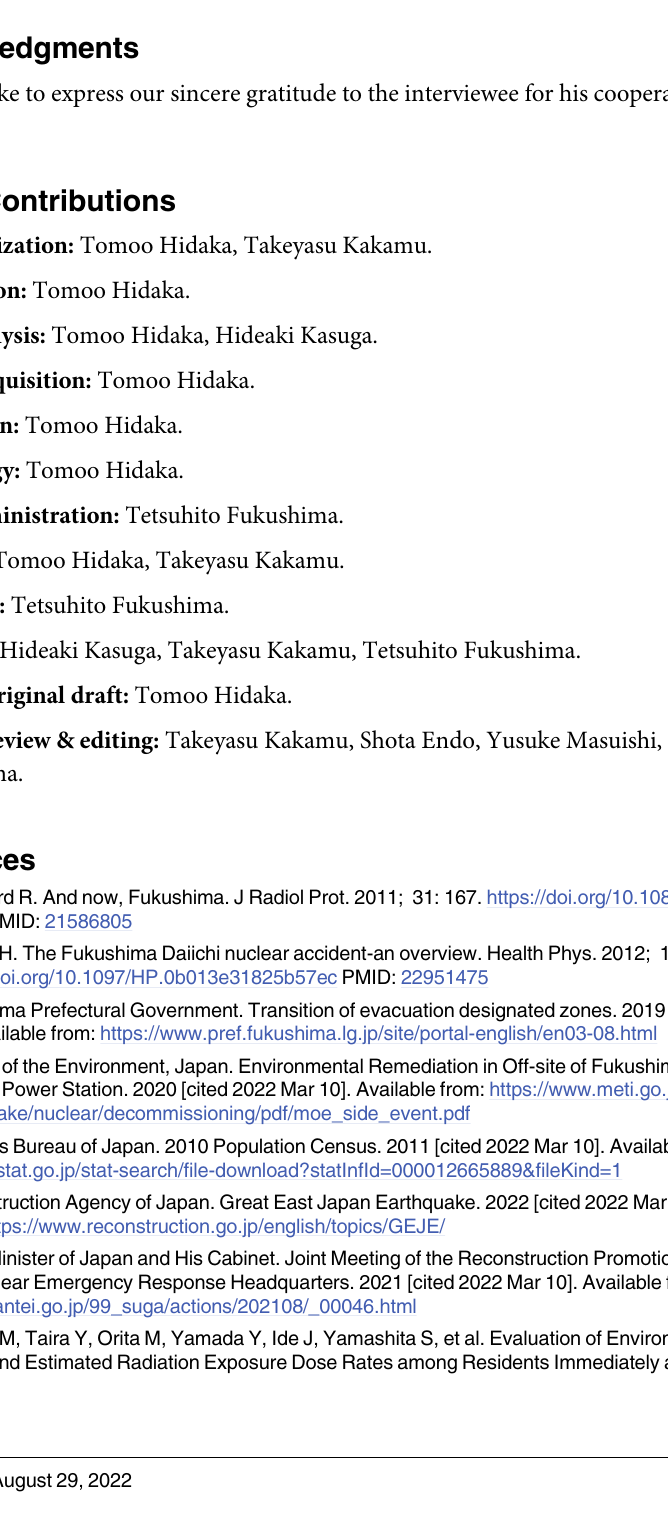
S1 Table. The SCAT coding form. S2 Table. The components of